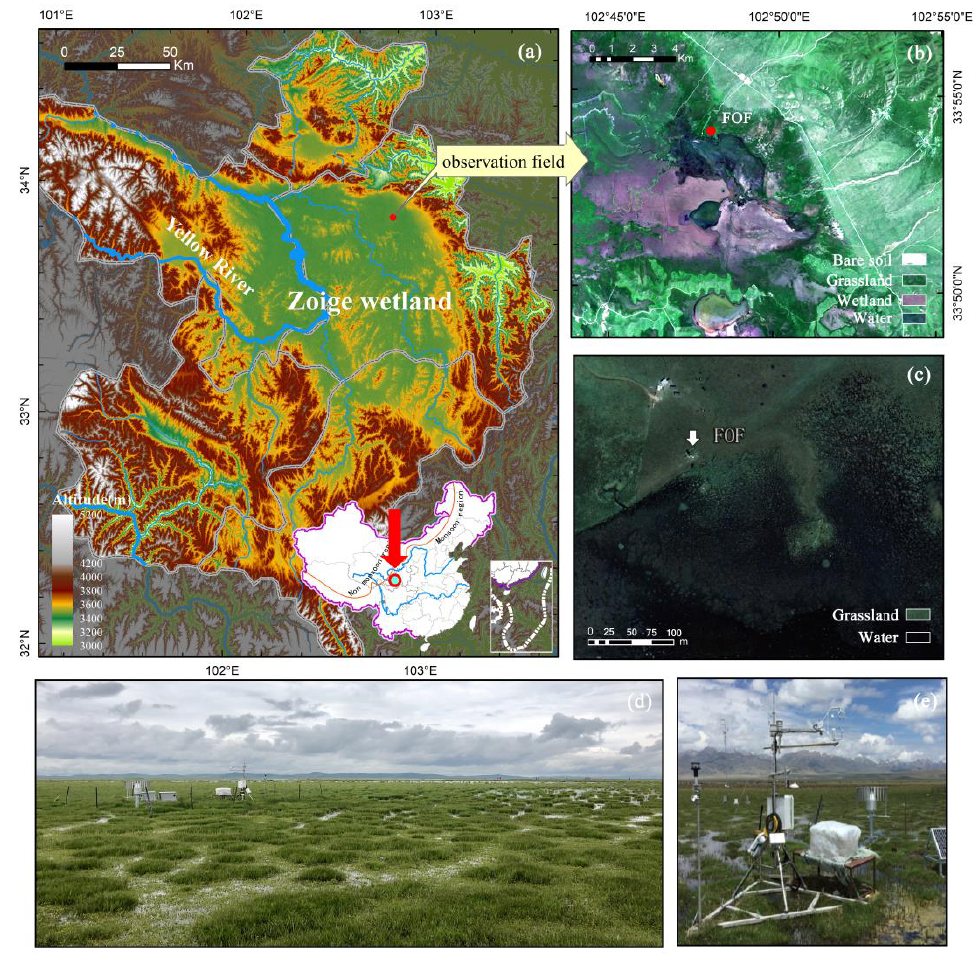
Figure 1. Topography of the study area ( a ), the pseudo-colour image of the Landsat/TM channels (B3, B2, and B1) (( b , c ), ( c ) is the sub-region covered by red point in ( b )), landscape ( d ), observational equipment ( e ).